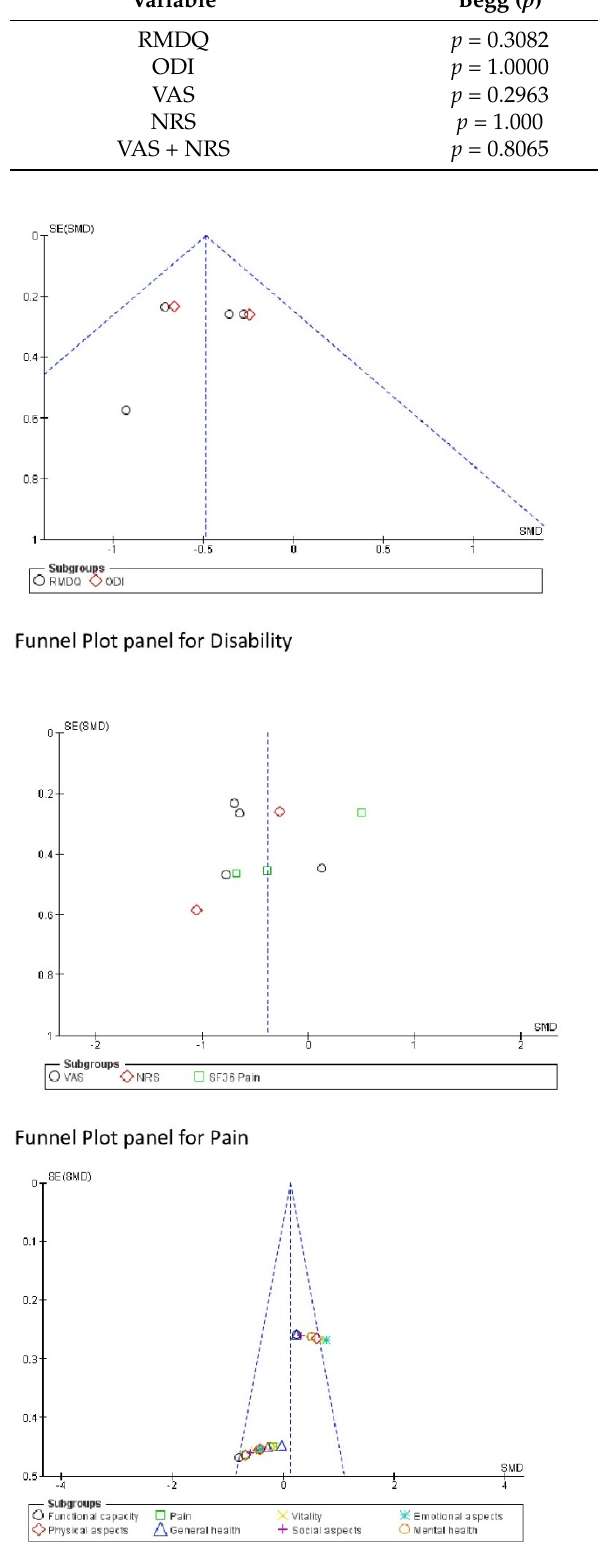
Figure 5. Publication bias.